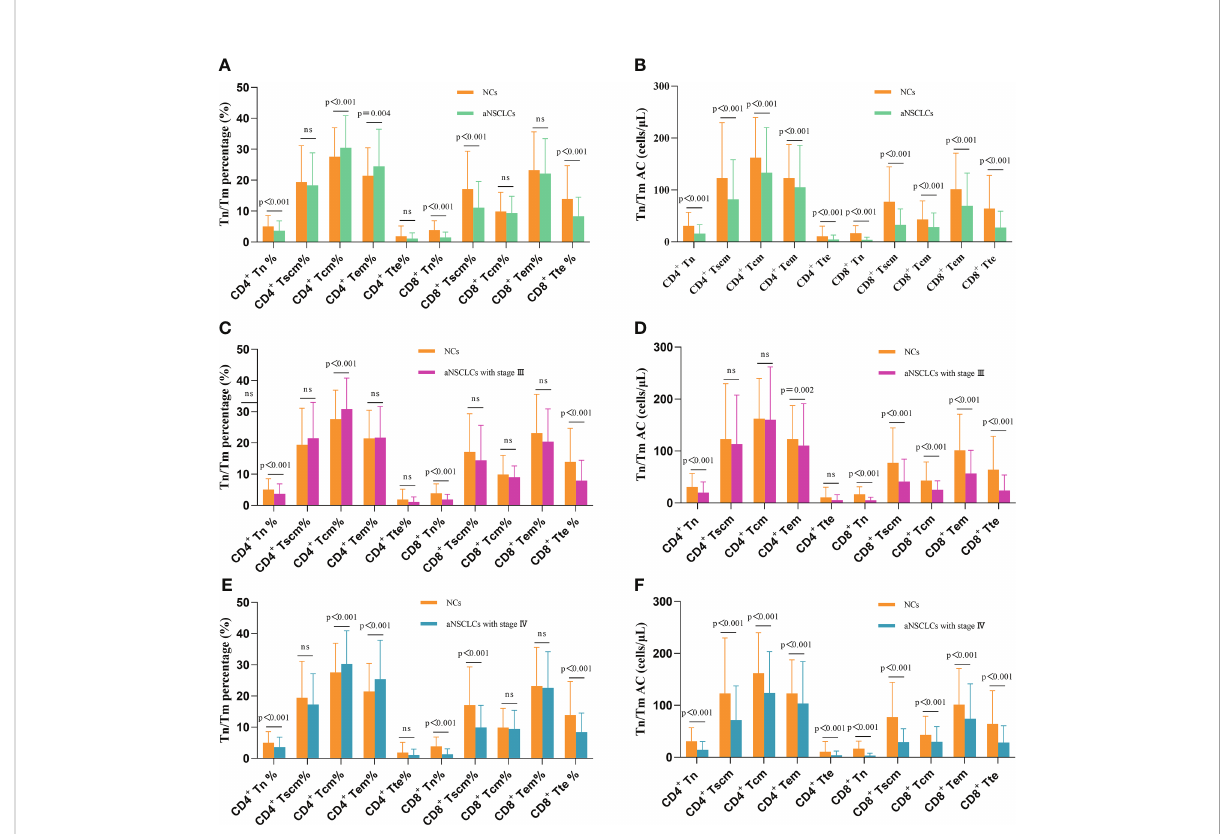
FIGURE 3 Comparison of Tn/Tm between aNSCLCs and NCs: (A) Comparison of percentages between aNSCLCs and NCs. (B) Comparison of AC between aNSCLCs and NCs. (C) Comparison of percentages between aNSCLCs with stage III and NCs. (D) Comparison of AC between aNSCLCs with stage III and NCs. (E) Comparison of percentages between aNSCLCs with stage IV and NCs. (F) Comparison of AC between aNSCLCs with stage IV and NCs. ns, no signi fi